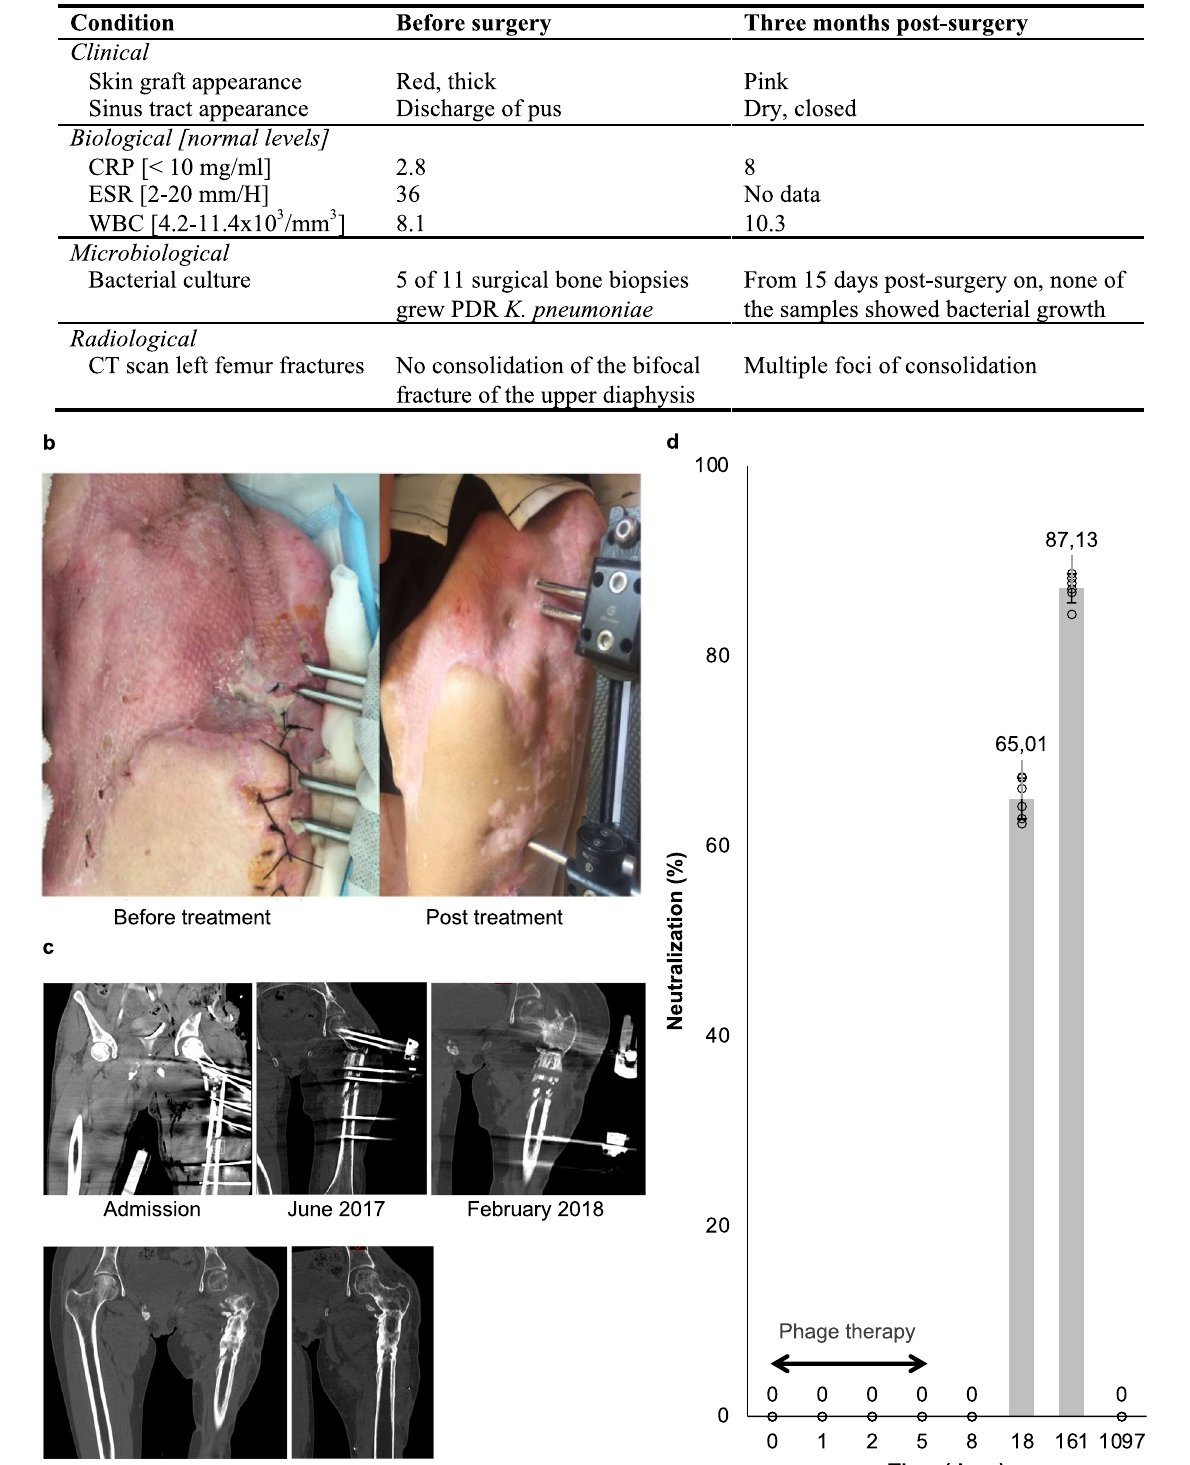
Fig. 7 Comparison of the patient ’ s condition before and after combined phage-antibiotic treatment. Relevant clinical, biological, microbiological, and radiological parameters before (within 3 days before, or – for microbiological parameters – during surgery) and after treatment ( a ). CRP, C reactive protein; CT, computed tomography; ESR, erythrocyte sedimentation rate; PDR pandrug-resistant, WBC white blood cells. Antero-external view of the patient ’ s left hip and thigh 18 months before and 3 months after treatment ( b ). Successive computed-tomography scanners of the left femur before (admission, June 2017 and February 2018) and after treatment (June 2018 and June 2019) ( c ). Neutralization of pre-adapted phage M1 by antibodies produced by the patient ’ s adaptive immune system upon phage treatment. Bars represent the mean values of biological replicates ( n = 6), each represented by a circle, with error bars representing standard deviations of the means ( d ). Source data are provided as a Source Data fi